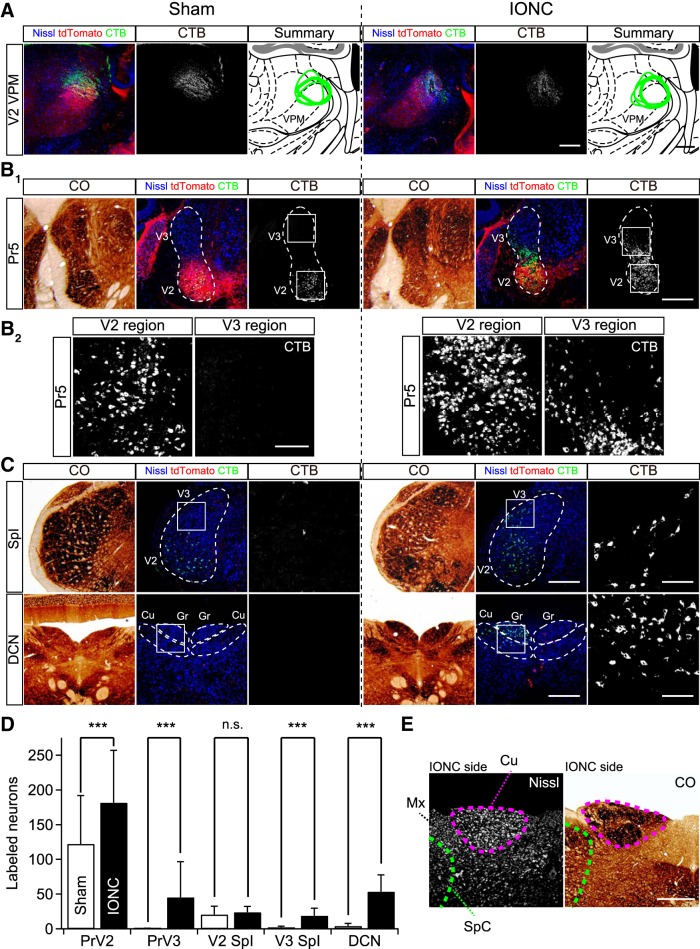
IONC induced lemniscal fiber innervations from non-V2 brainstem nuclei to V2 VPM. A, A solution containing CTB, an efficient neural tracer, was injected in the right V2 VPM of sham (left)- or IONC (right)-operated Krox20-Ai14 mice to retrogradely label projection neurons terminating the V2 VPM. Injection sites of analyzed mice were reconstructed as green enclosures on the brain atlas of Franklin and Paxinos (2008). Injection sites shown as pictures were depicted by thick lines. Scale bars, 400 µm. B, Retrogradely labeled neurons in the V2 and V3 regions of the Pr5 in sham (left) and IONC (right). See Materials and Methods for details regarding identification of V2 and V3 regions. CO-stained adjacent sections are also shown (B1, leftmost). Squared regions in B1 are magnified in B2. Scale bars for low (B1) and high (B2) magnifications, 400 and 100 µm, respectively. C, Retrogradely labeled neurons in the interpolar subnucleus of the spinal trigeminal nuclei (SpI), and the DCNs in sham (left) and IONC (right). CTB-immunofluorescence of squared regions is magnified in the rightmost and CO-stained adjacent sections are also shown (leftmost). Scale bars for low and high magnifications, 400 and 100 µm. Cu, cuneate nucleus; Gr, gracile nucleus. D, Summary bar graph showing numbers of retrogradely labeled neurons from the V2 VPM. Values are represented as mean ± SD. Three and four mice (four ROIs of separate sections from each animal) were examined for sham and IONC groups, respectively. Statistical significance was tested by two-way repeated measures ANOVA (main effect of IONC). ***p < 0.001; n.s., not significant; two-tailed. E, Nissl- and CO-stained adjacent brainstem sections of an IONC-operated mouse showing Cu and the caudal subnucleus of the spinal trigeminal nuclei (SpC) in the ipsilateral side of IONC. Clear cyto-architecture was retained; there is no collapse of boundaries between Cu and SpC. Mx, matrix region of the medulla. Scale bar, 400 µm.